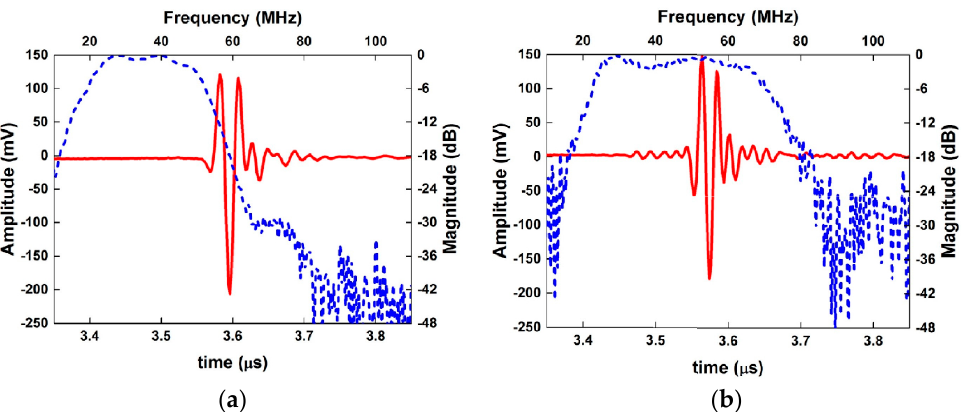
Figure 16. Needle ultrasonic transducer with filter based electric impedance matching network. Reproduced with permission from Reference [120], Copyright Elsevier, 2016.